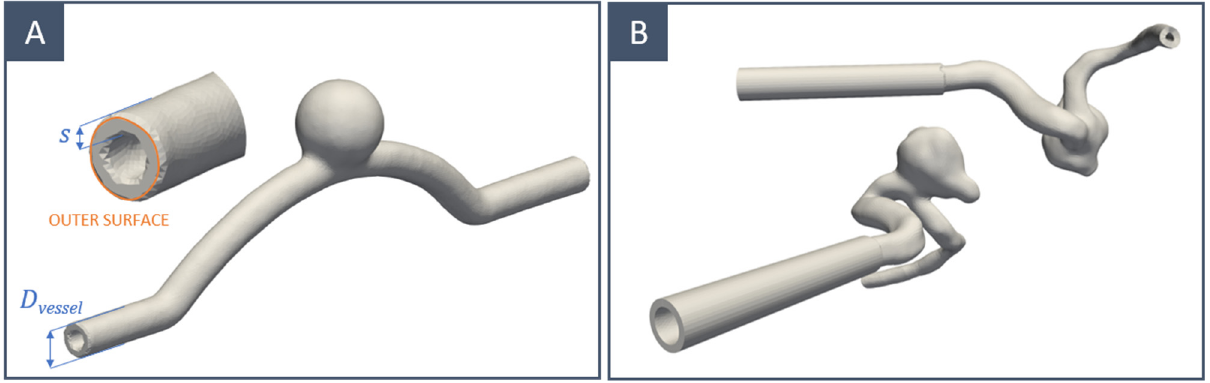
Figure 2. CAD geometry with offset for the inner mould of ( A ) idealised and ( B ) patient-specific geometry.